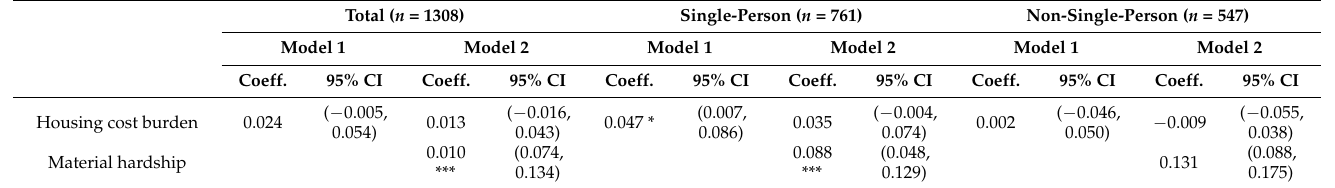
Table 5. Log-linear model: association between housing cost burden, material hardship and depressive symptoms. Total ( n =